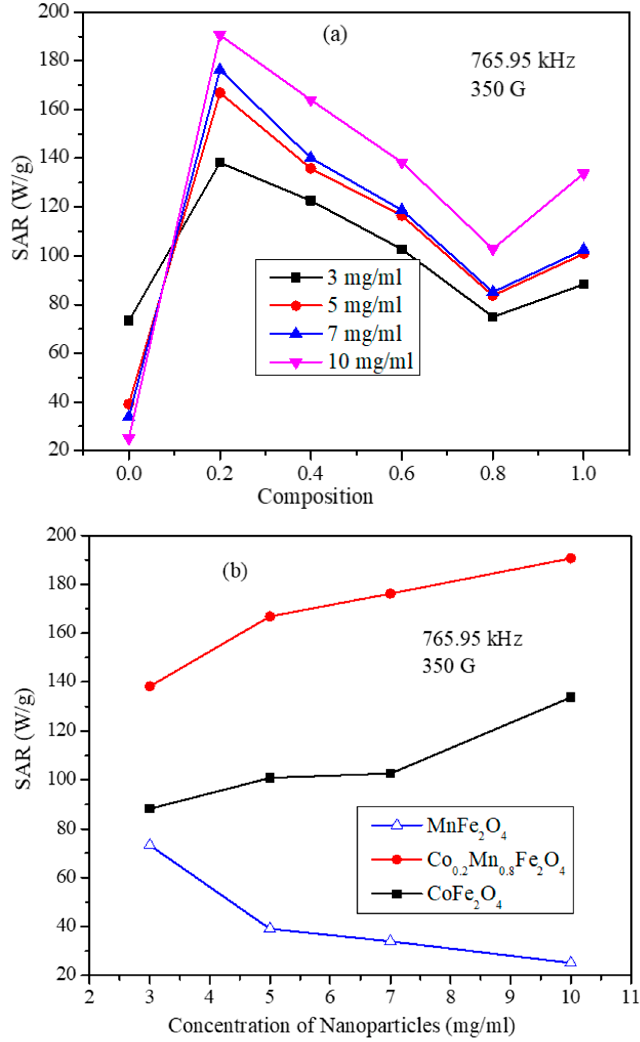
Figure 8. ( a ) SAR values as a function of the compositions Co x Mn 1-x Fe 2 O 4 ( x = 0, 0.2, 0.4, 0.6, 0.8, and 1.0) nanoparticle with concentrations of 3, 5, 7, and 10 mg/mL at 765.95 kHz frequency and 350 G field strength. ( b ) Concentration dependent SAR of MnFe 2 O 4 , CoFe 2 O 4 , and Co 0.2 Mn 0.8 Fe 2 O 4 nanoparticles at 765.95 kHz frequency and 350 G field strength (lines are just guides for the eye). As shown in Figure 8b, the nanoparticles with composition Co 0.2 Mn 0.8 Fe 2 O 4 possess the maximum SAR value (190.61 W/g for 10 mg/mL concentration at 765.95 kHz and 350 G). These particle dispersions were examined further for frequency and field strength dependency along with CoFe 2 O 4 nanoparticles. The frequency and field strength depen- dent SAR values for the samples Co 0.2 Mn 0.8 Fe 2 O 4 and CoFe 2 O 4 are shown in Figure 9a,b. The SAR values were obtained for 10 mg/mL concentration at fixed field strength of 350 G with variable field frequencies and at fixed frequency of 765.95 kHz with variable field strengths. The frequency dependent SAR values of the CoFe 2 O 4 nanoparticles show a roughly linear behavior. On the other hand, the SAR values of the Co 0.2 Mn 0.8 Fe 2 O